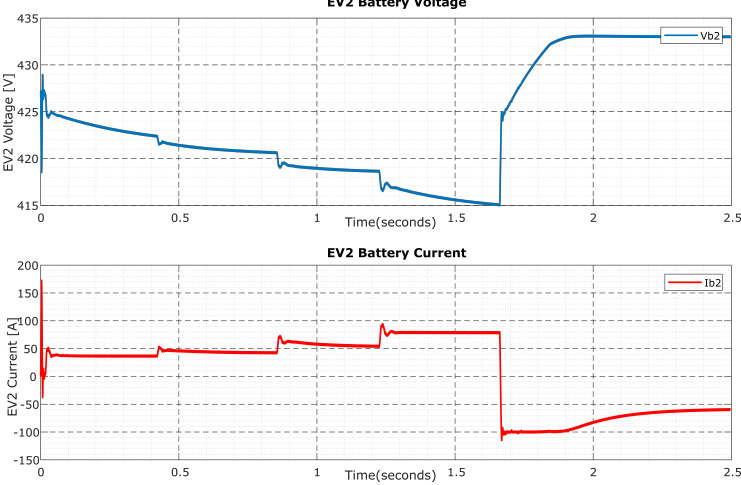
Figure 14. Illustration of CC and CV in both Mode1 and Mode2 [21], © 2021